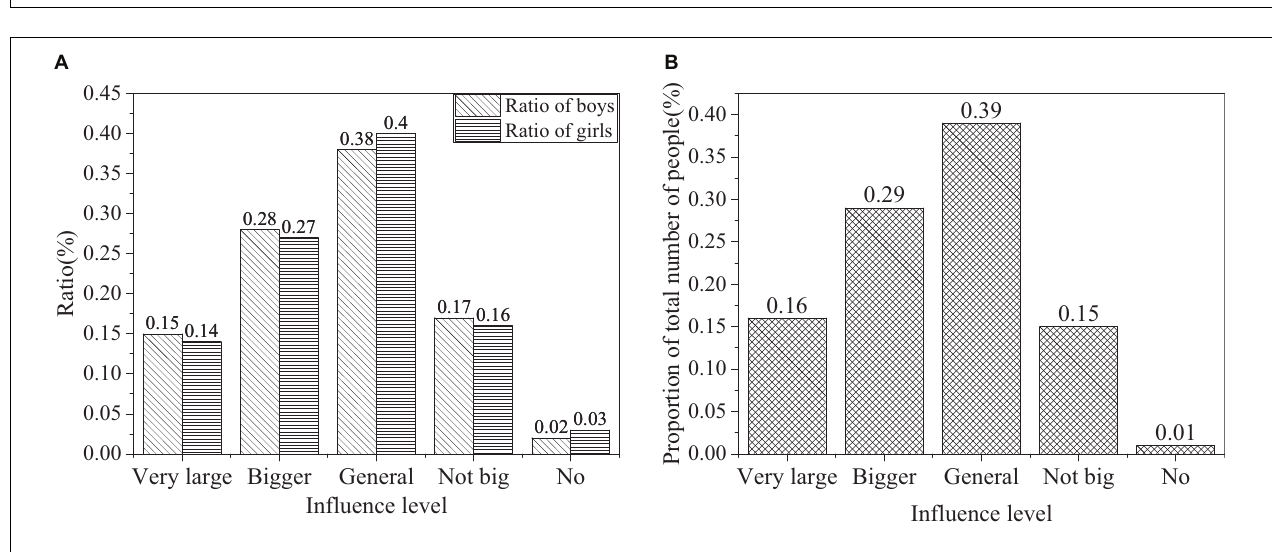
FIGURE 5 | Influence of network information on the attitudes of college students toward politics [ (A) the ratio of males and females; (B) the ratio of all].